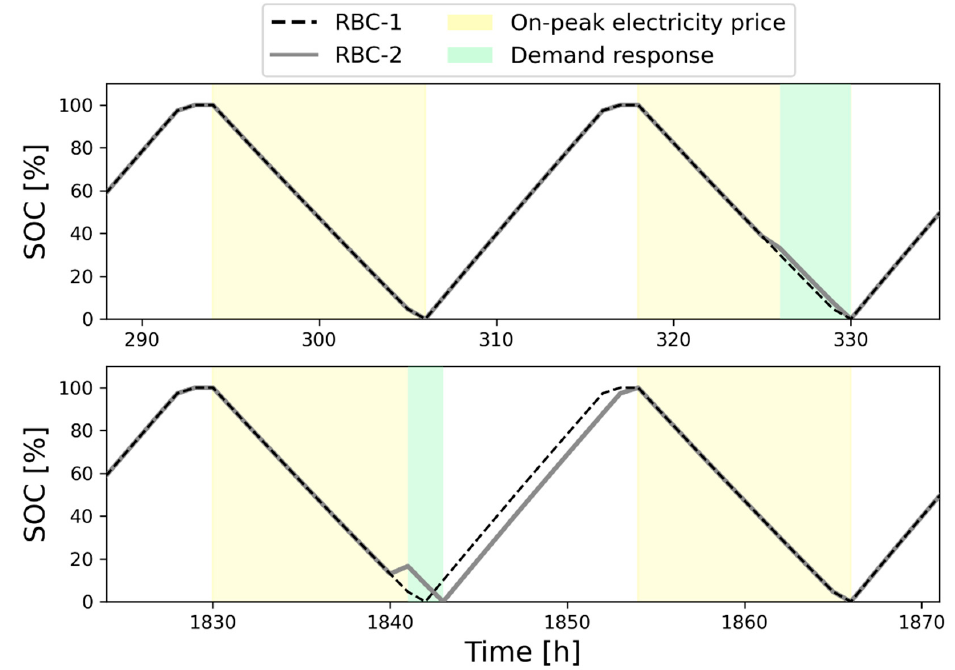
Figure 5. State of charge profiles of a cooling storage determined by the control actions of the two RBC controllers.